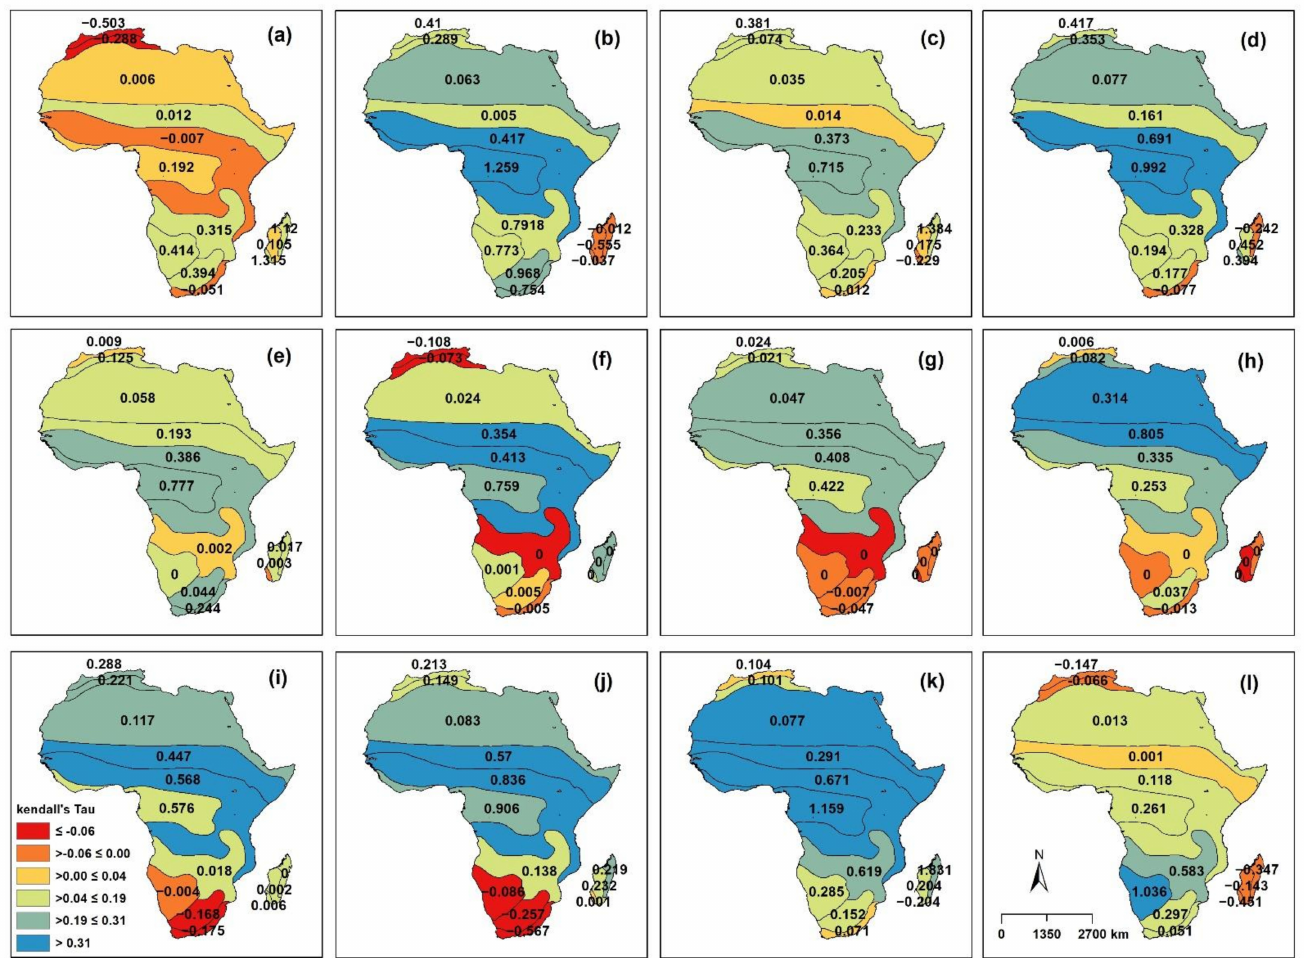
Figure 10. Kendall’s Tau (colour gradient) and Sen’s slope (numbers) for monthly rainfall trends in different climate zones of Africa including Madagascar between 1983 and 2020. ( a ) January, ( b ) February, ( c ) March, ( d ) April, ( e ) May, ( f ) June, ( g ) July ( h ) August, ( i ) September, ( j ) October, ( k ) November and ( l )